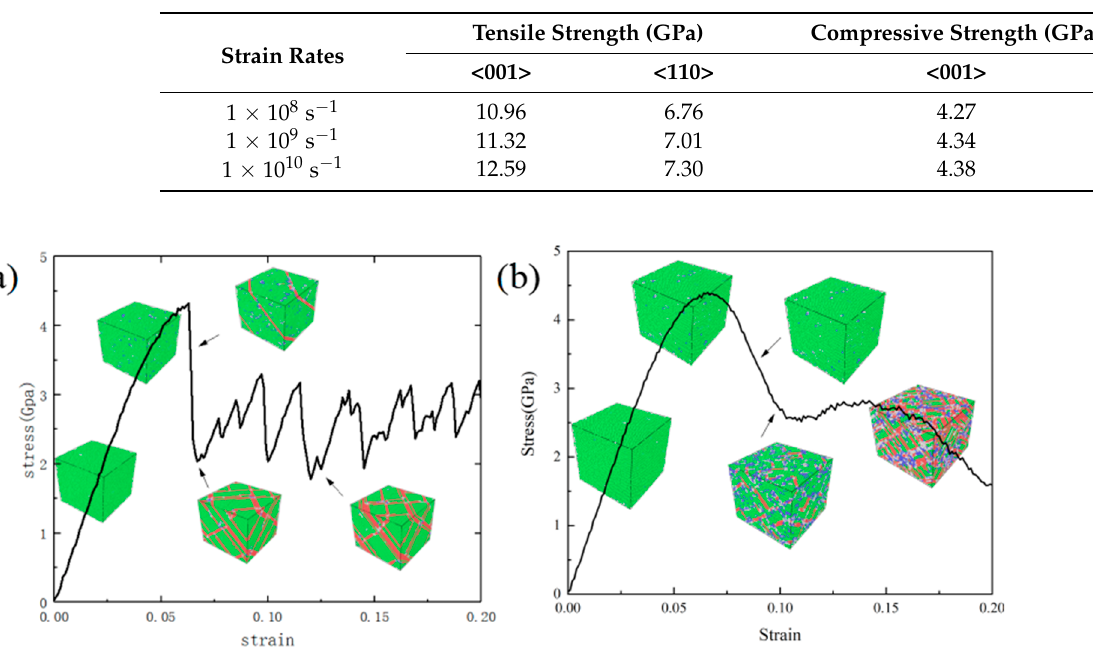
Figure 6. Stress and structural evolution of CoCrNi SCs at strain rates of 1 × 10 8 s − 1 ( a ) and 1 × 10 10 s − 1 ( b ). Green, blue, and red represent the atoms of FCC, BCC, and HCP structures, respectively.